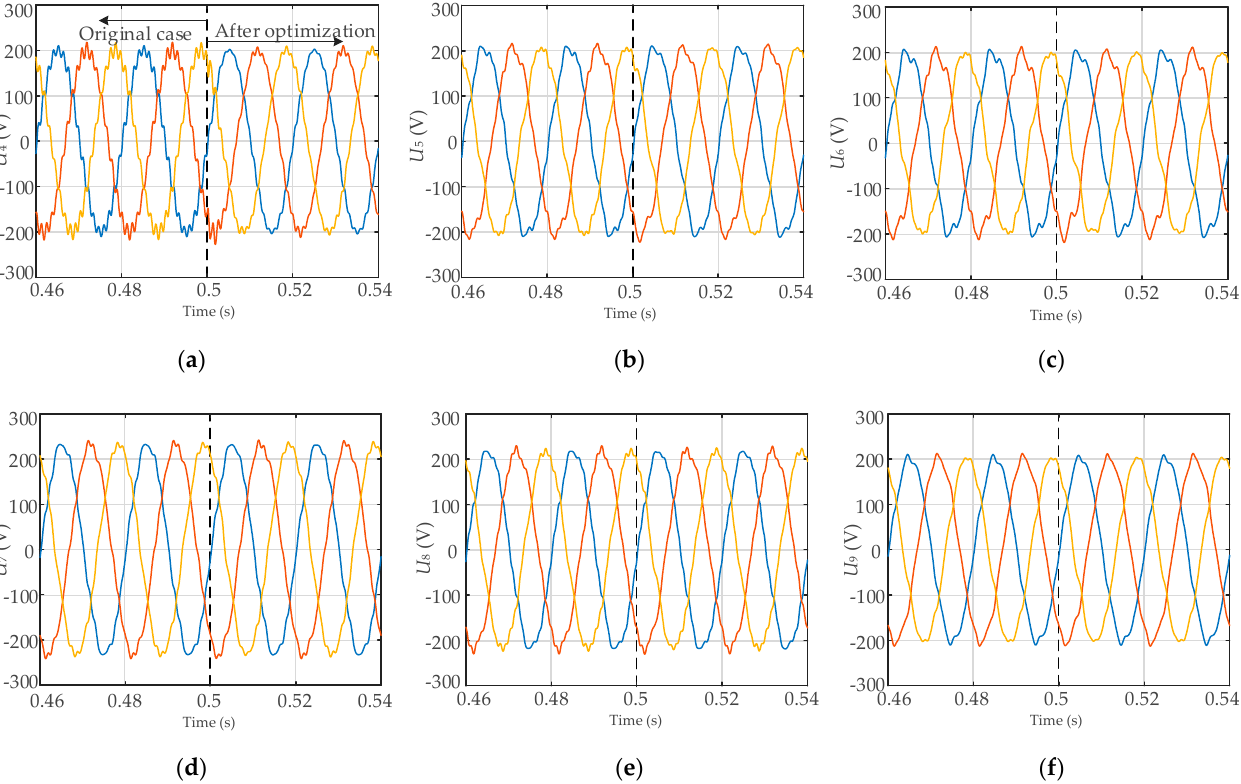
Figure 17. the voltage waveform of the original case and after optimization. ( a ) bus 4. ( b ) bus 5. ( c ) bus 6. ( d ) bus 7. ( e ) bus 8. ( f ) bus 9.